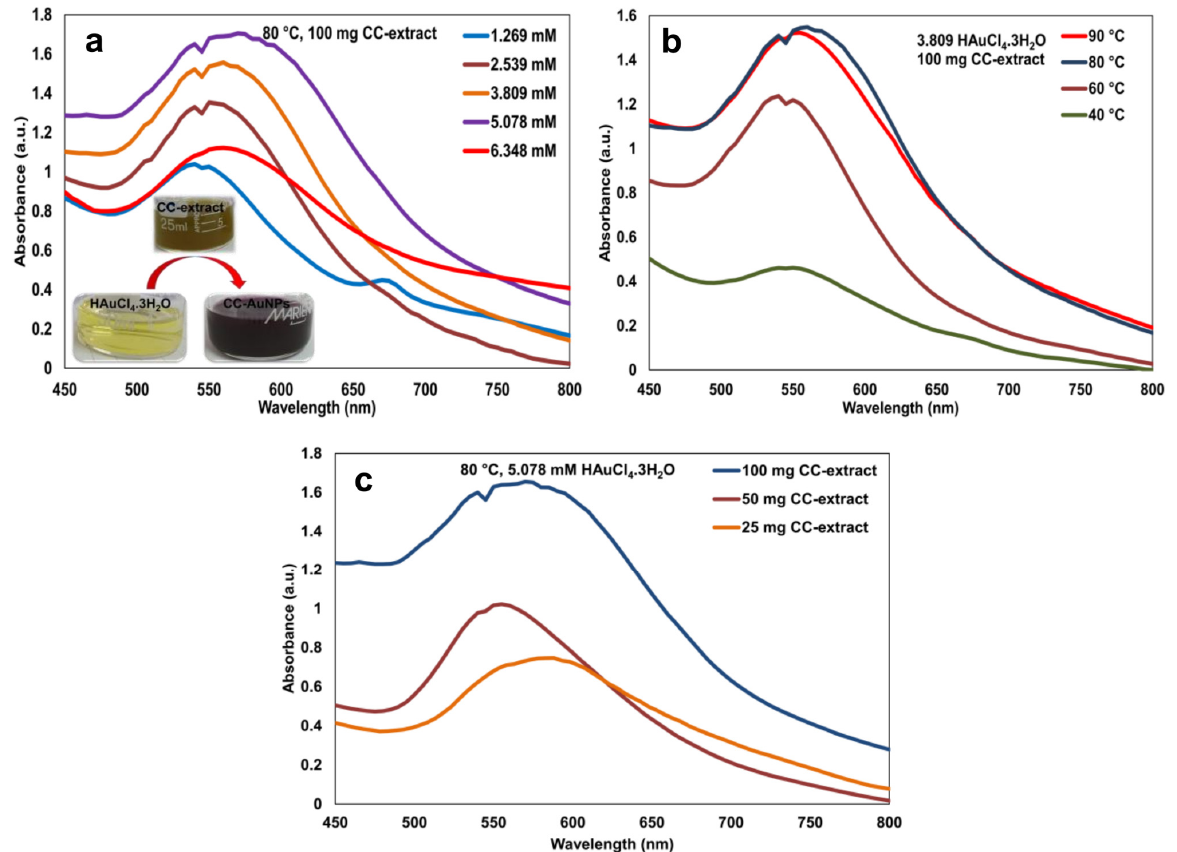
Figure 1. UV–Vis absorption spectra of CC-AuNPs: ( a ) various concentrations of HAuCl 4 · 3H 2 O (6.348 mM, 5.078 mM, 3.809 mM, 2.539 mM, and 1.269 mM), ( b ) various temperatures (40, 60, 80, and 90 °C), and ( c ) various CC-extract concentrations (25, 50, and 100 mg).